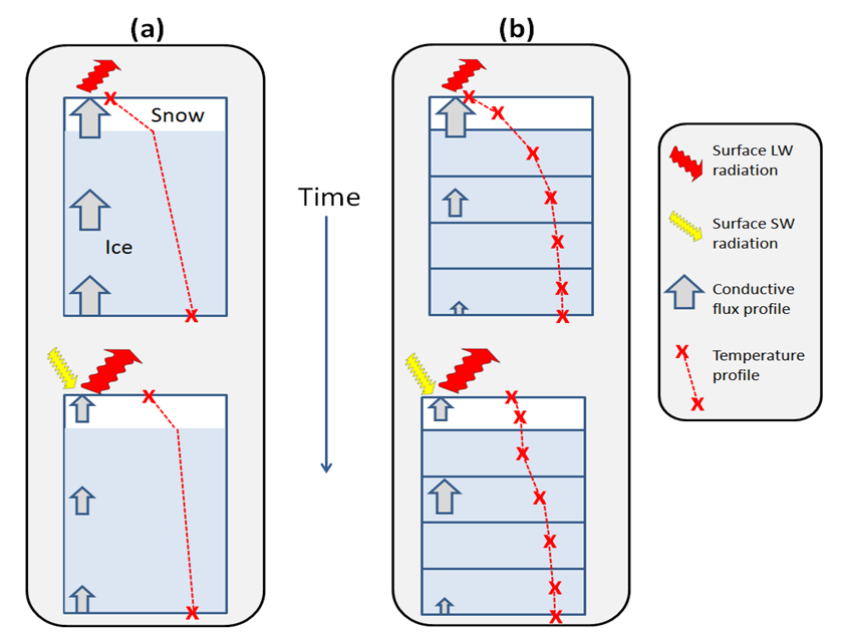
Figure 1. Schematic demonstrating the time evolution of ice temperature, following an increase in downward short wave surface flux, for (a) the GSI6 zero-layer ice thermodynamics scheme; (b) the GSI8 multilayer scheme.